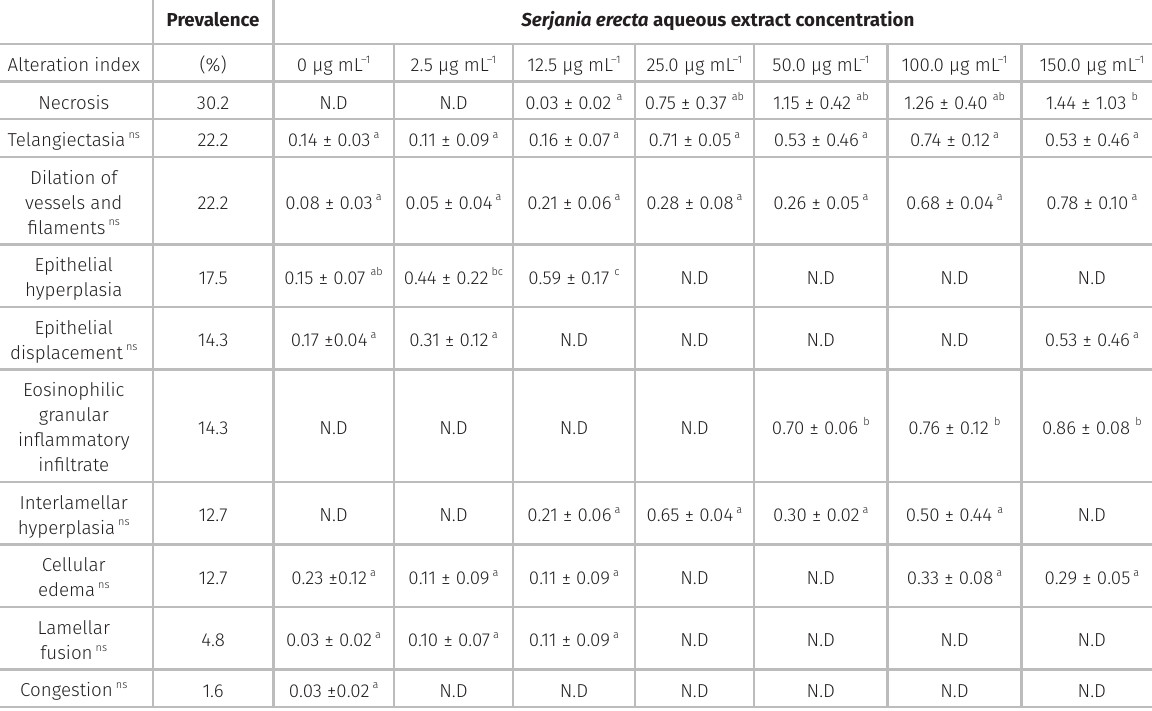
Table IV. Prevalence of alterations in the gills of Piaractus mespotamicus exposed to concentrations of Serjania erecta aqueous